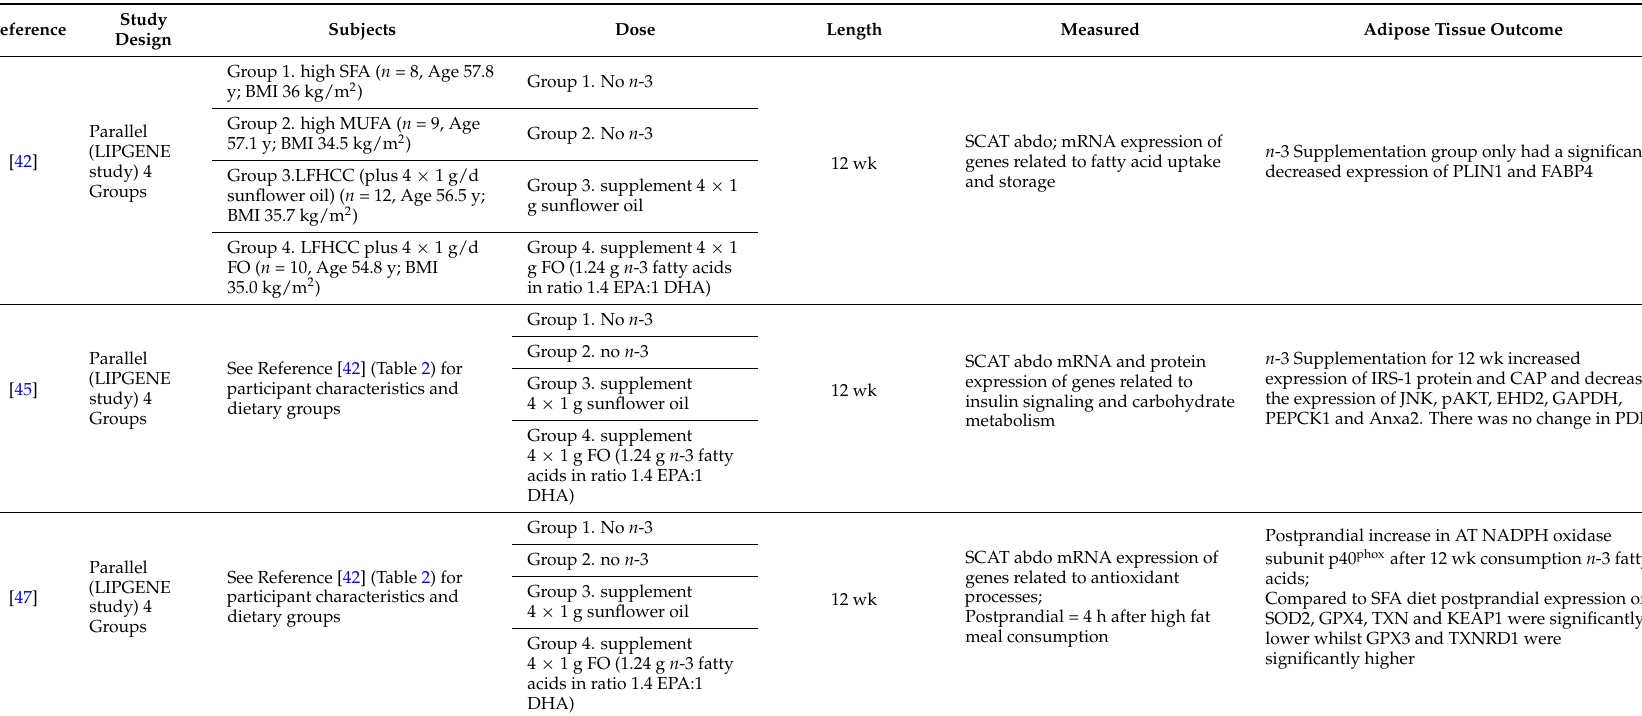
Table 2. Overview of human studies investigating the effect of EPA and DHA supplementation on markers of adipose tissue metabolism and function.